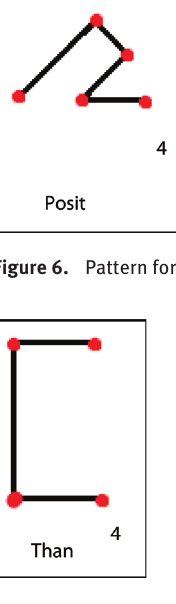
Figure 7. Pattern for